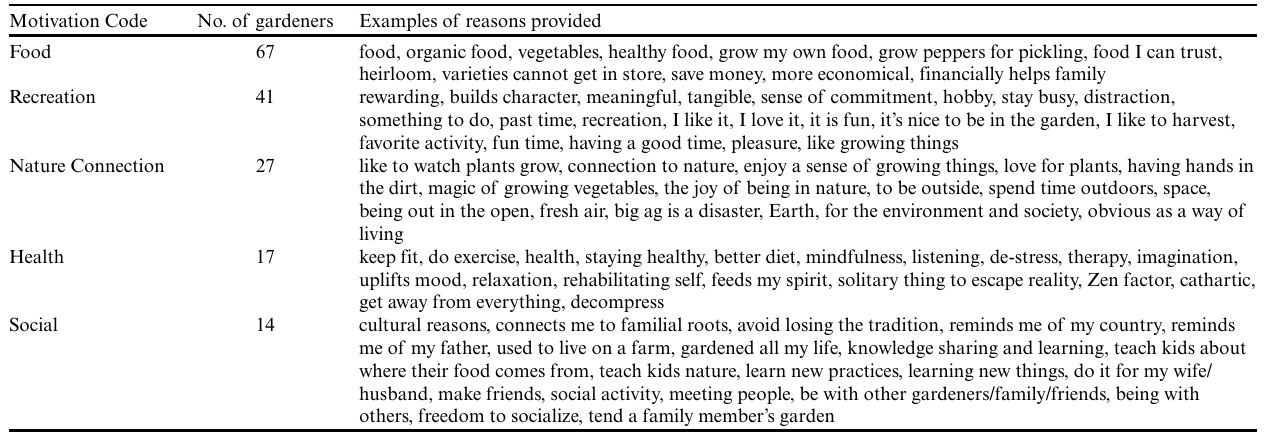
Table 2 . Codebook for gardener motivations named as a top motivation by urban gardeners in the central coast of California. Codes included as a factor in the model analysis.